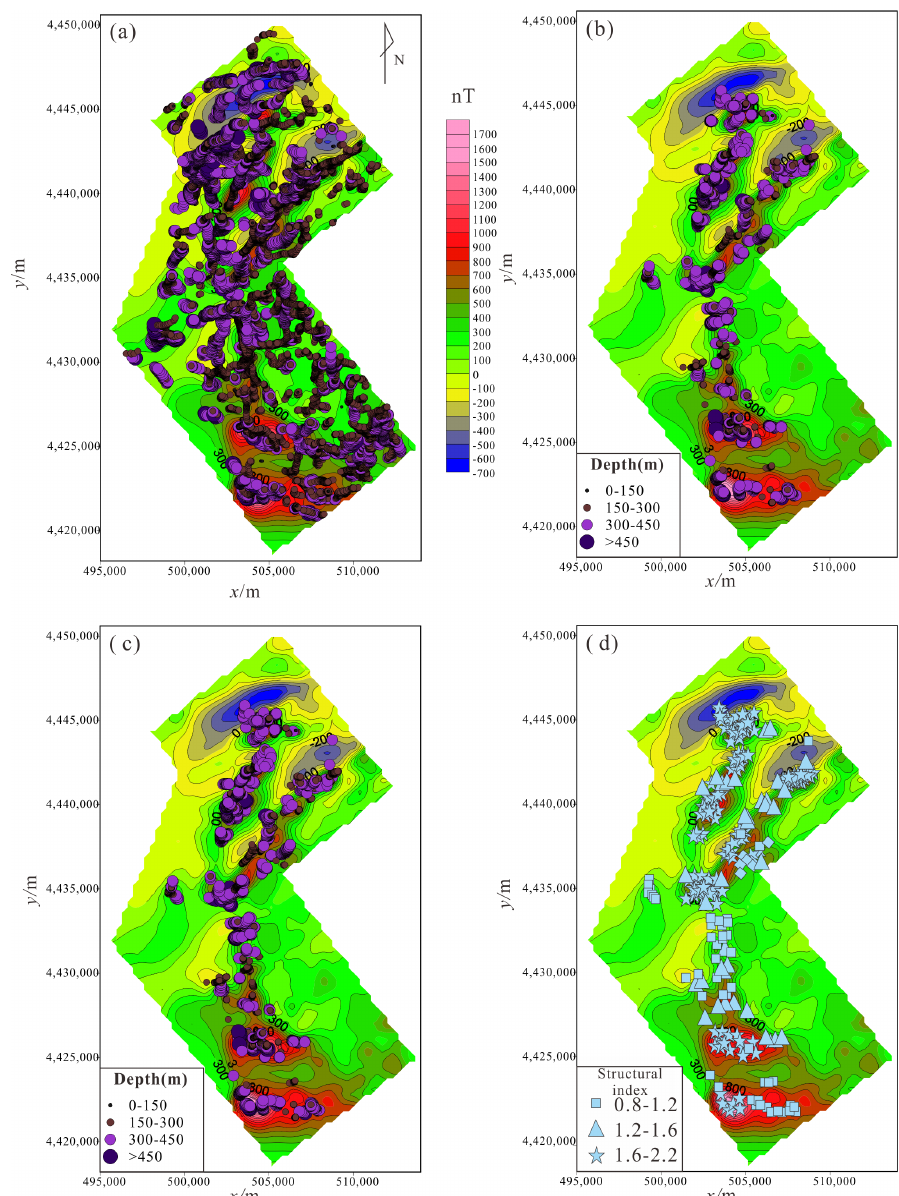
Figure 9. ( a ) Source location obtained by estimator C1; ( b ) source locations obtained by estimator Cd; ( c ) source locations obtained by estimator Bd; ( d ) structural index obtained by estimator